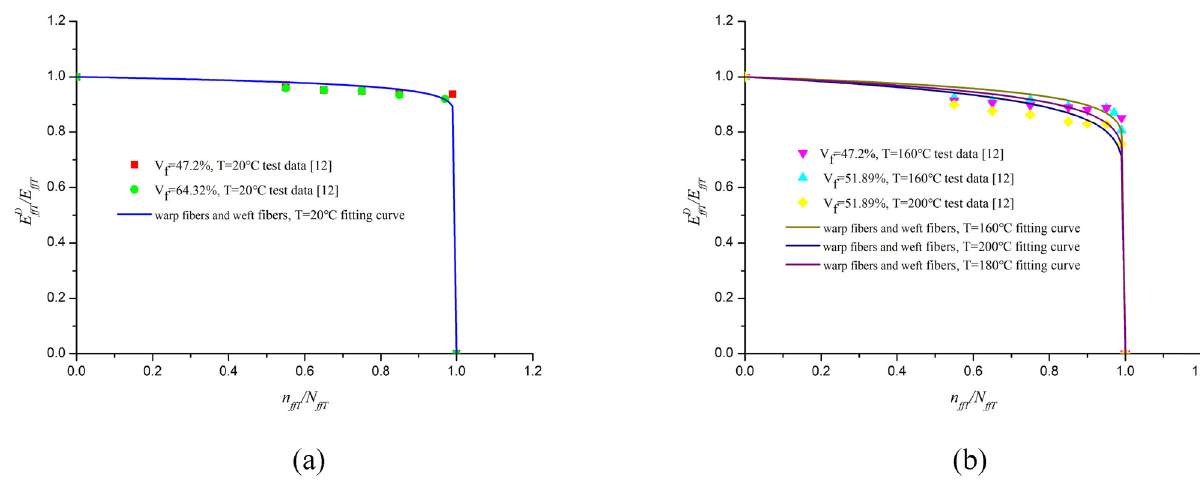
Figure 6: The fi tting curve of the normalized residual sti ff ness vs the normalized fatigue life of [ 0 ] n unidirectional plies at ( a ) 20°C and ( b ) 180°C.